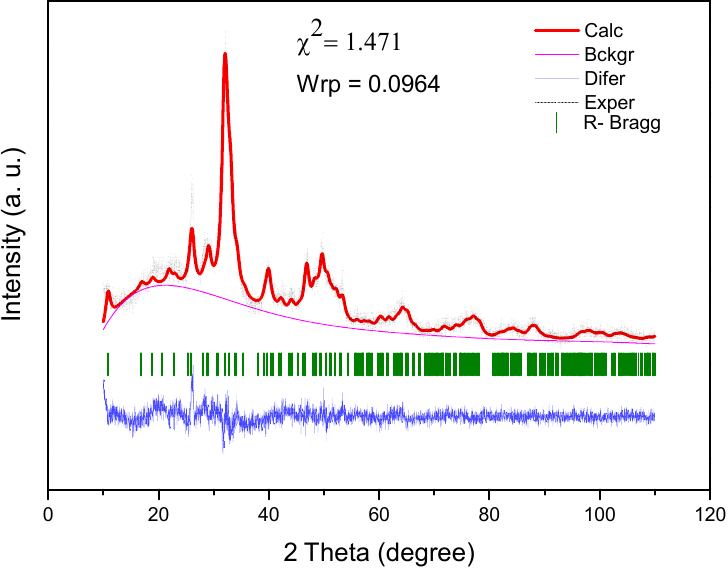
Figure 3. Rietveld refinement of S HG scaffold.